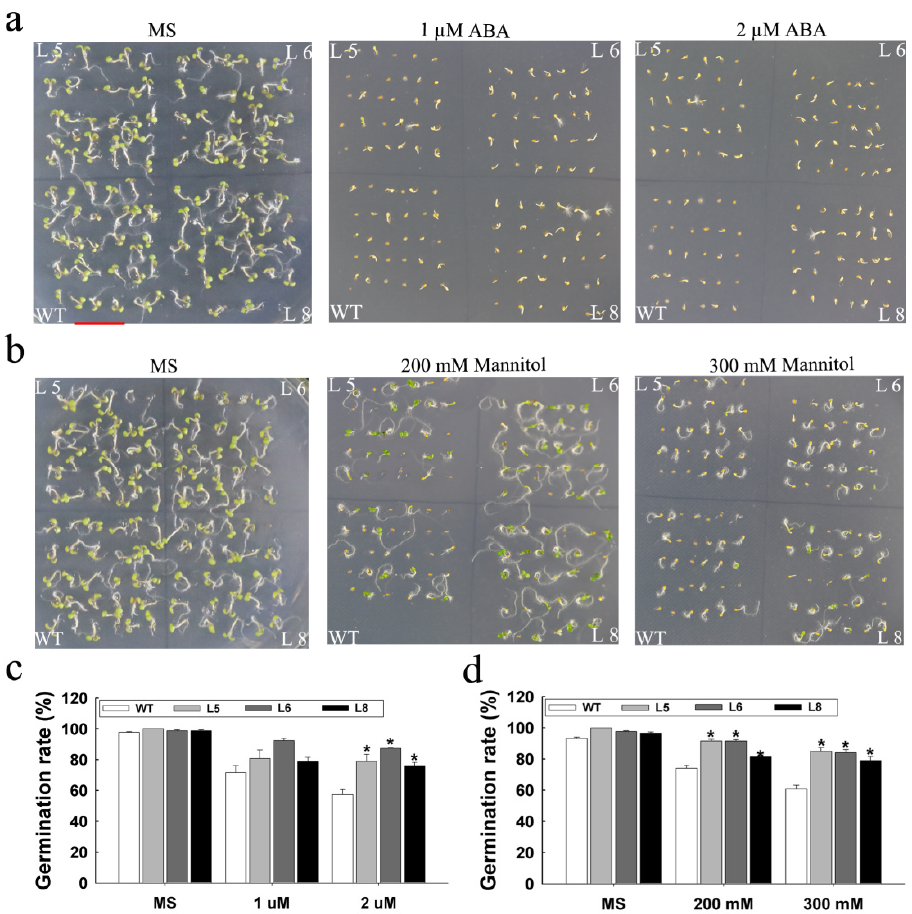
Figure 5. ABA and mannitol stresses tolerance of LcSAIN3 transgenic Arabidopsis plants at germi- nation stage. ( a , c ) seed germination rates of the WT and LcSAIN3 -expressing lines were measured on MS media and MS media containing 1 and 2 µ M ABA. ( b , d ) Seed germination rates of the WT and LcSAIN3 -expressing lines were measured on MS media and MS media containing 200 and 300 mM mannitol. Thirty seeds were allowed to grow for seven days after sowing, and each column represents an average of three replicates; the bars indicate standard deviations (SDs). * indicates significant differences in comparison with the control at p < 0.05. Scale bar = 1 cm.